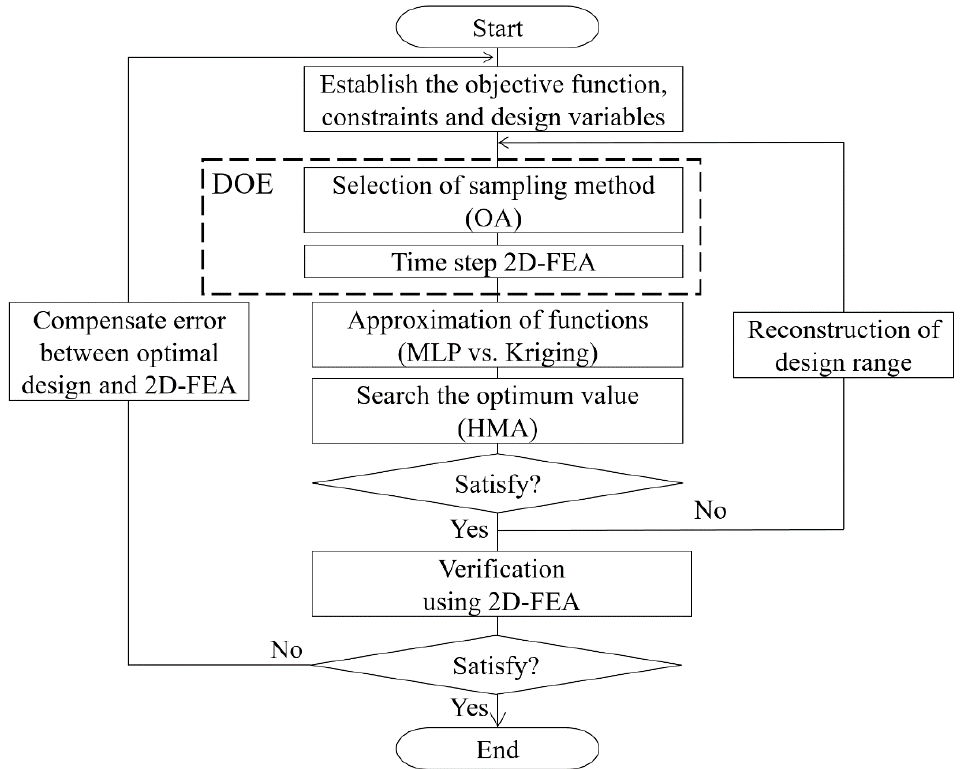
Figure 4. Optimization design process.